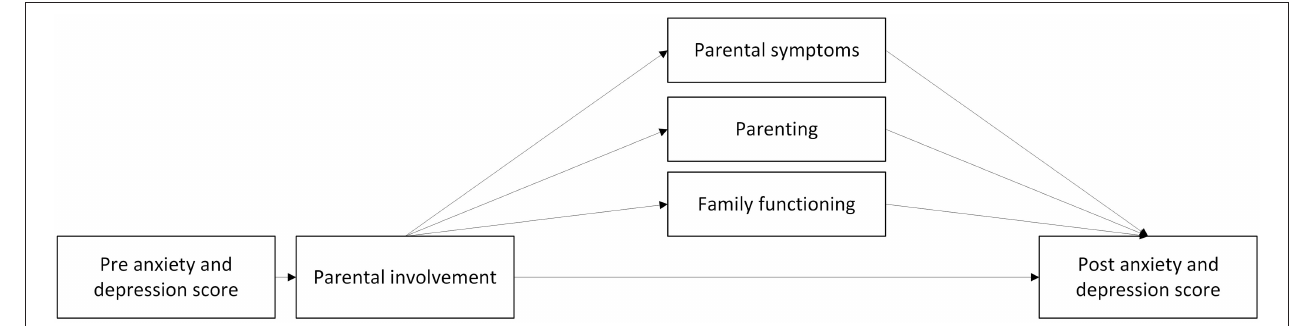
FIGURE 3 | Proposed mediators of change with the parental involvement component.